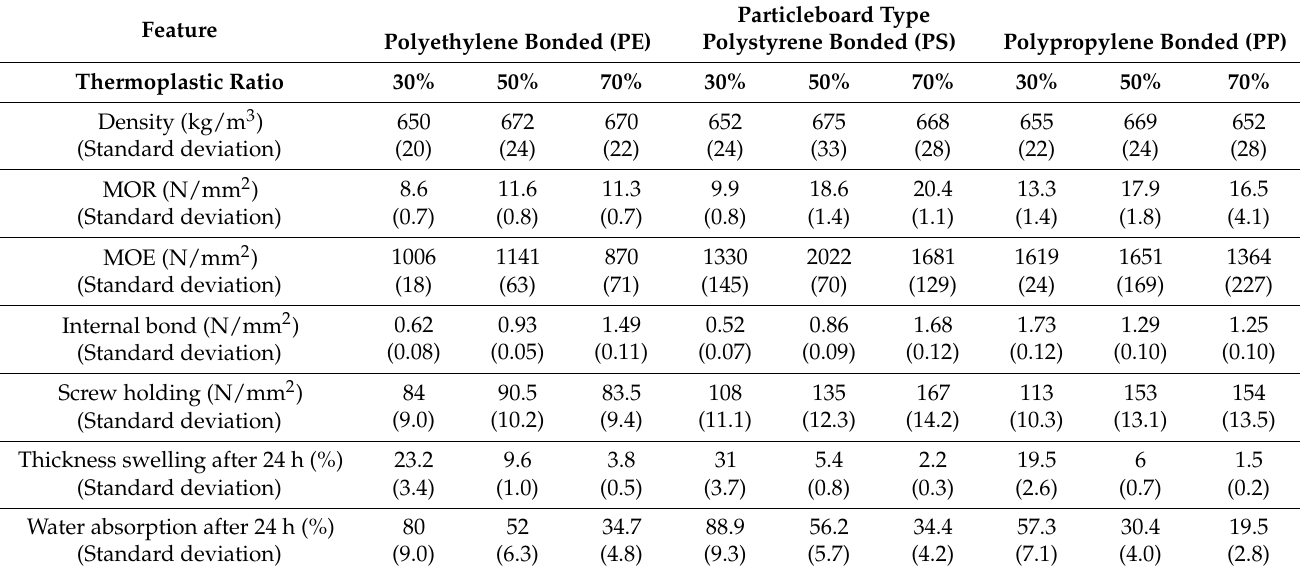
Table 2. Detailed Information about the Wood-Plastic Particleboards which were